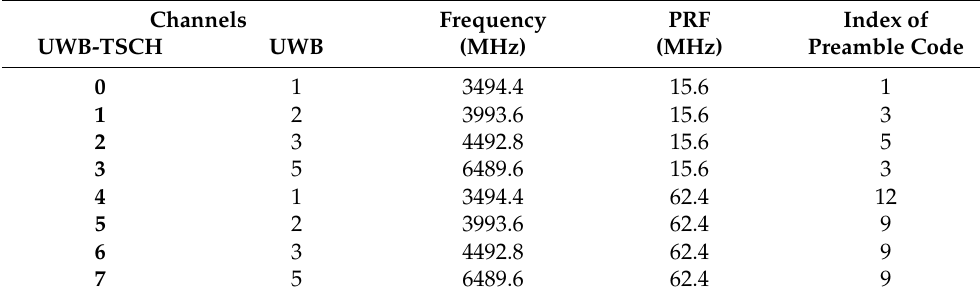
Table 1. Channels used in UWB-TSCH. All of them can be used concurrently as they use either different frequencies or different orthogonal preamble codes and pulse repetition frequency